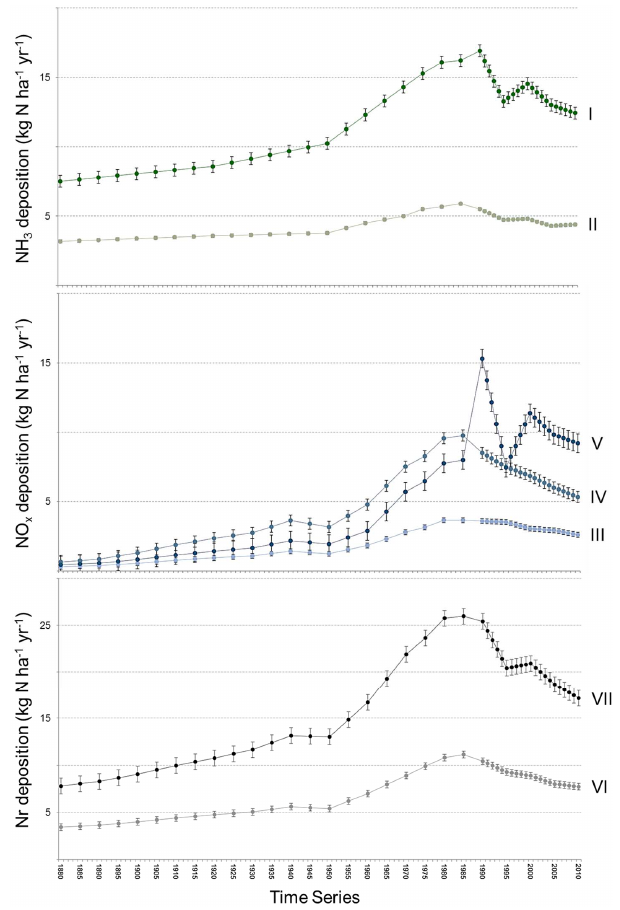
Figure 2. Temporal cluster vector means (averages and standard errors of the series) of the depositions of NH 3 (upper panel), NO x (middle panel) and Nr (lower panel) across Europe. The colours and Roman numerals correspond to those used for the clusters in Fig. 1. Nitrogen deposition did not increase during the 1940s and started to rise again shortly after the introduction of the Marshall Plan in Europe. The time series for Deposition Cluster V (NO x ) , encompassing 408 sites located in the Po Valley (Italy) subject to local thermic inversion, is the only trend that suddenly intercepts other trends when the resolution of the data set increases from 5- year calculations (1880–1990) to yearly observations